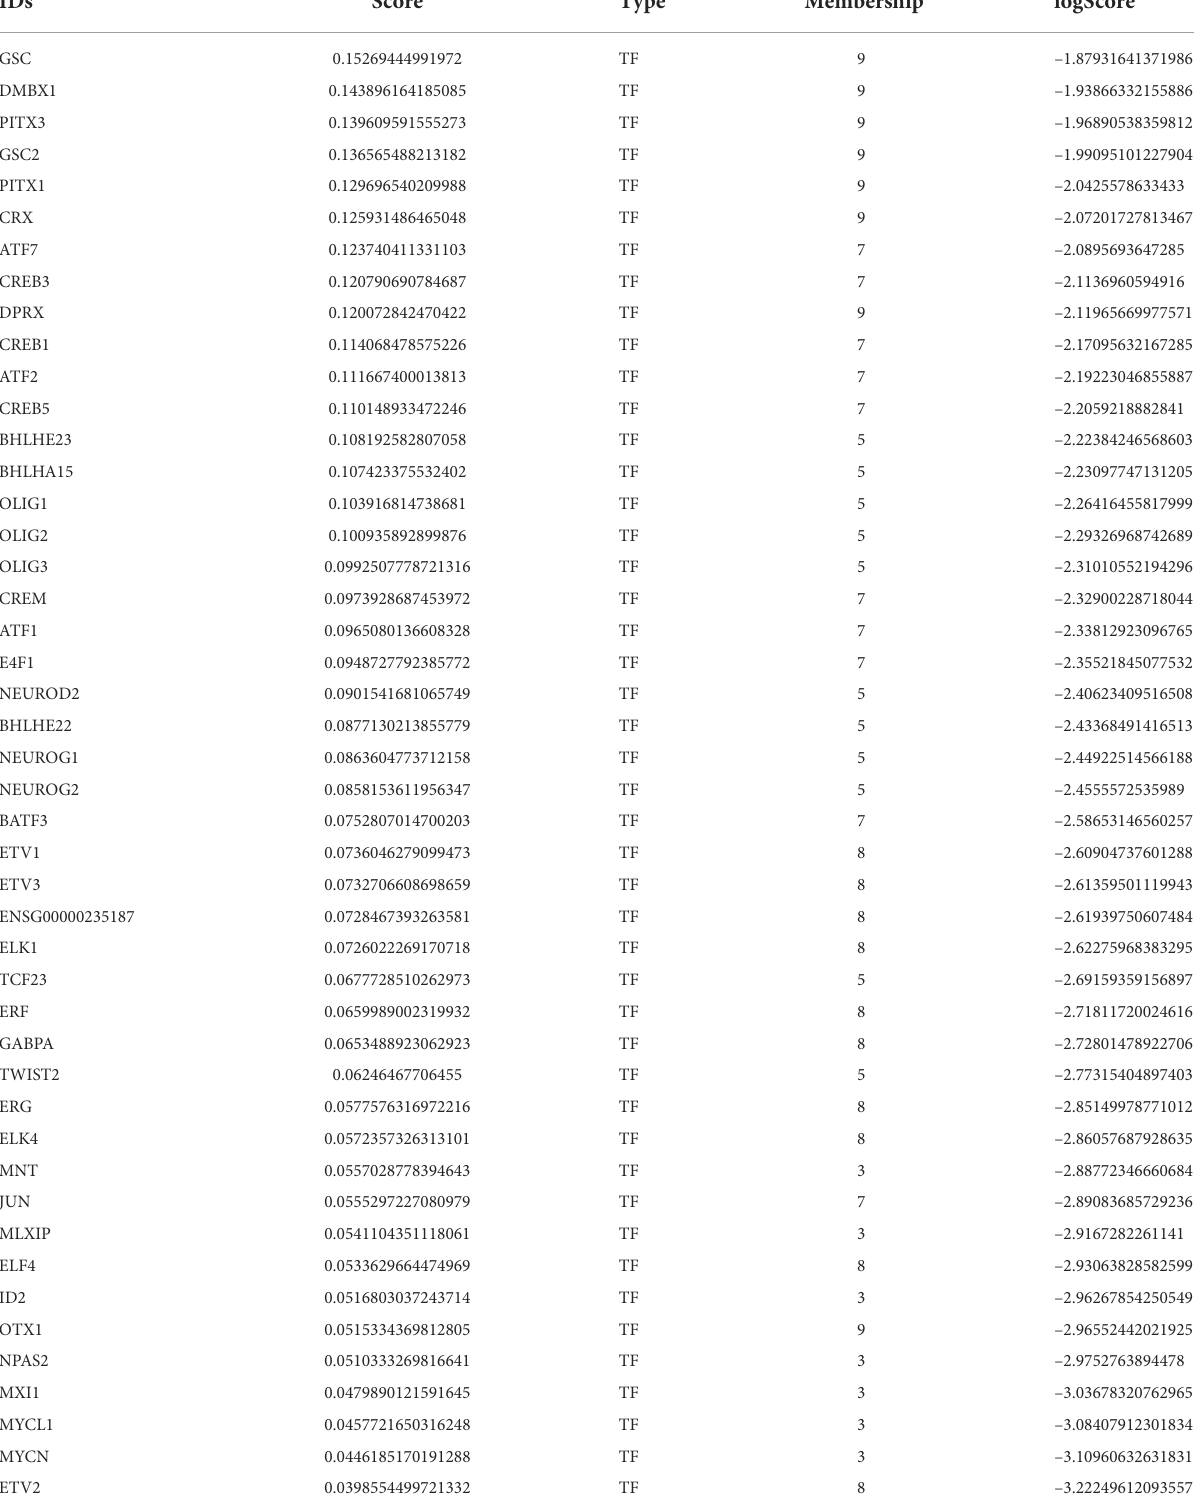
TABLE 2 Female-biased TFs with the highest scores of differential